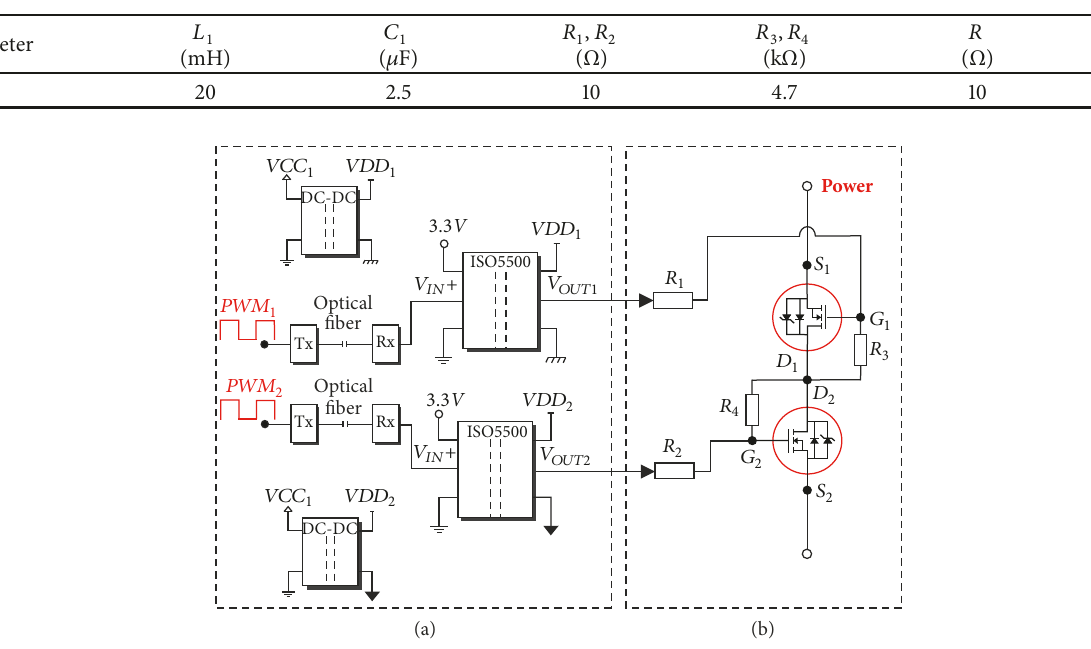
Table 2: Parameters of the Bi-Sw experimental setup.